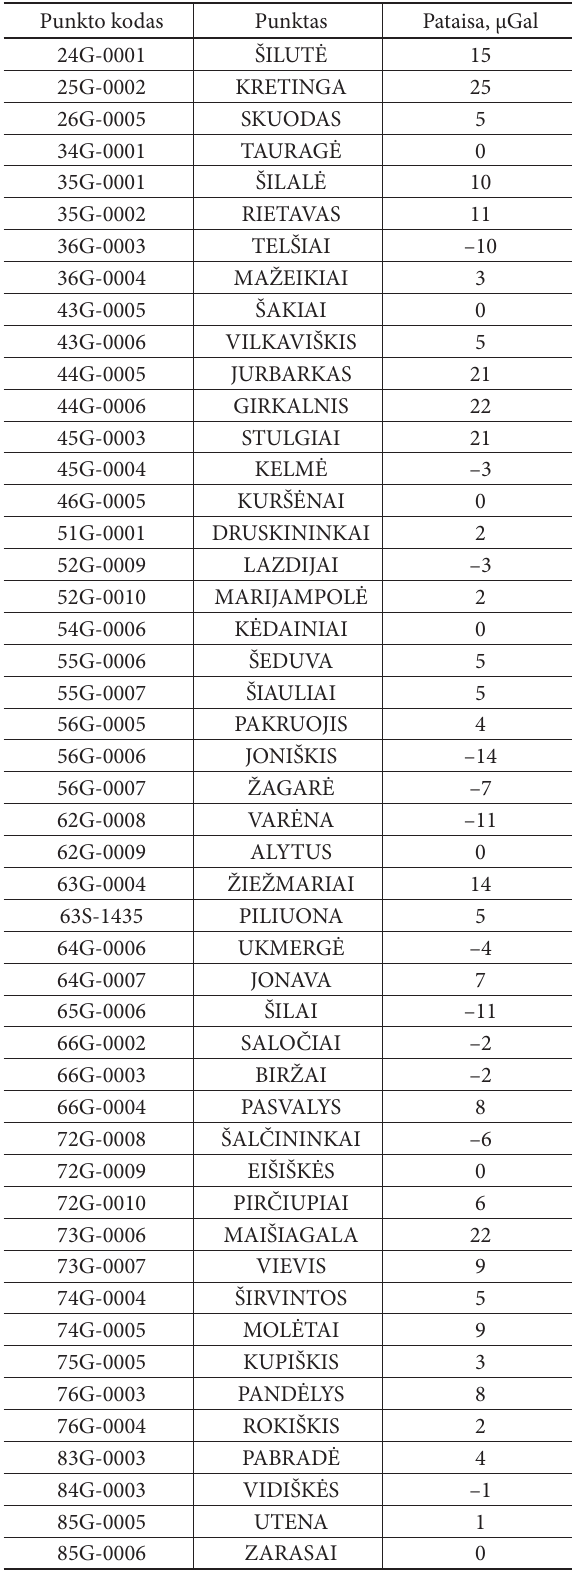
Table 3 . Gravity acceleration corrections at the first order gravimetric points, µGal Punkto